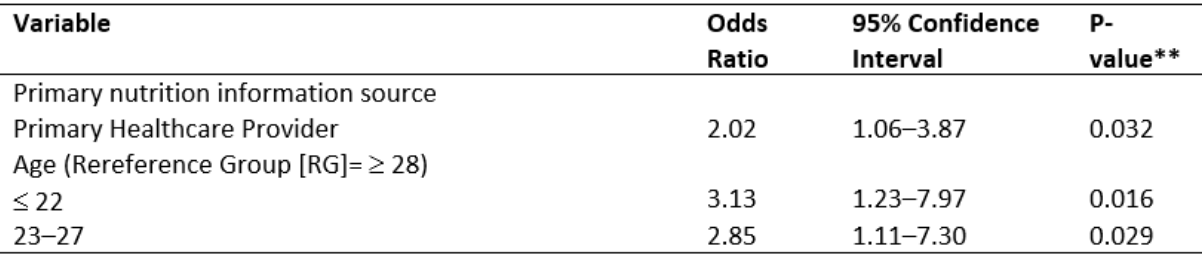
Table 4. Reduced* multivariable logistic regression results of variables influencing first year Canadian and US veterinary students’ self -reported trust in family doctors recommending certain diets showing significant variables, odds ratios, 95% confidence intervals, and significance values